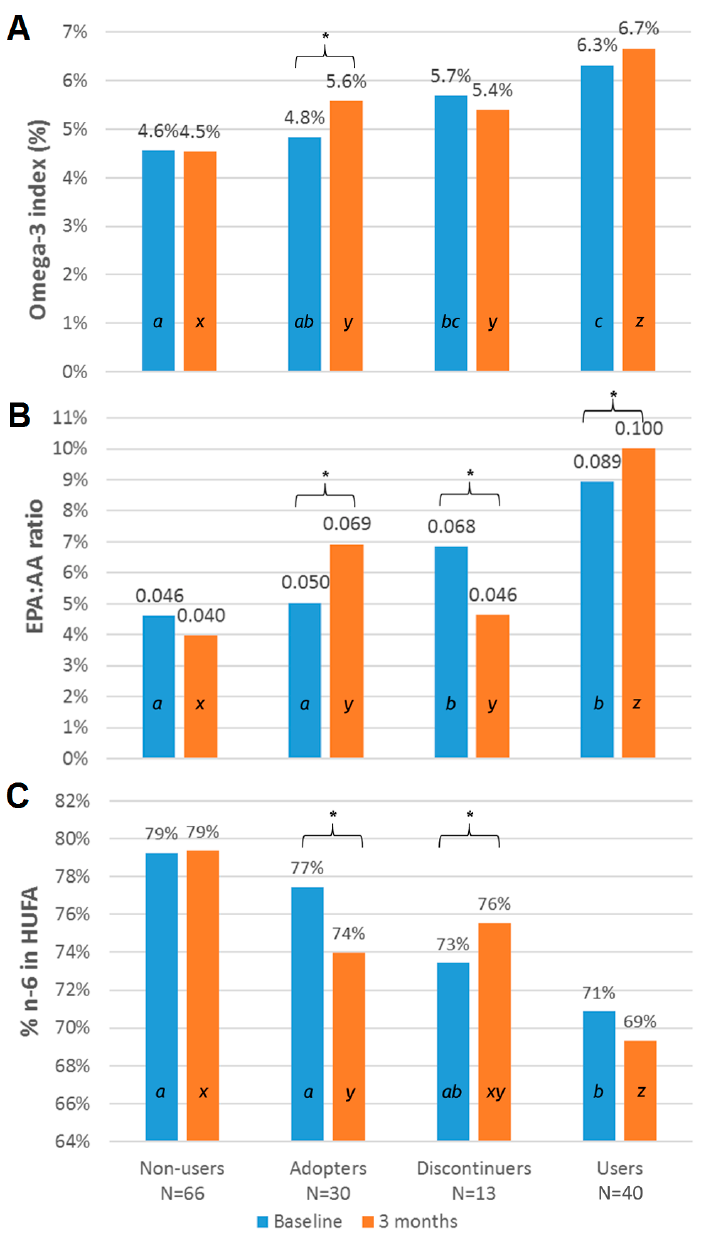
Figure 3. Blood fatty acid measures versus omega-3 intake according to omega-3 supplement use at baseline and three months (n = 149) for ( A ) omega-3 index or ( B ) EPA:AA ratio or ( C ) percent n6 in highly unsaturated fatty acids (HUFA). Statistical differences ( p < 0.05) among means for Non-Users, Adopters, Discontinuers, and Users within a blood fatty acid measurement ( A , B , or C ) at baseline are denoted by a, b, c and at three months by x, y, z. * denotes a significant difference within an omega-3 use category between baseline and three months.